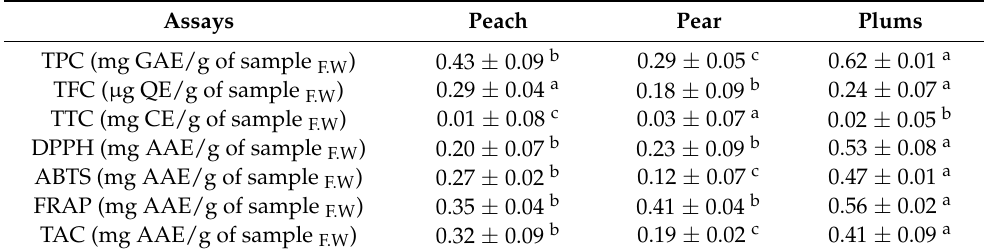
Table 1. Phenolic estimation and antioxidant activity evaluation of peaches, pears, and plums. Assays Peach Pear Plums TPC (mg GAE/g of sample F.W ) 0.43 ± 0.09 b 0.29 ± 0.05 c 0.62 ± 0.01 a TFC ( µ g QE/g of sample F.W ) 0.20 ± 0.07